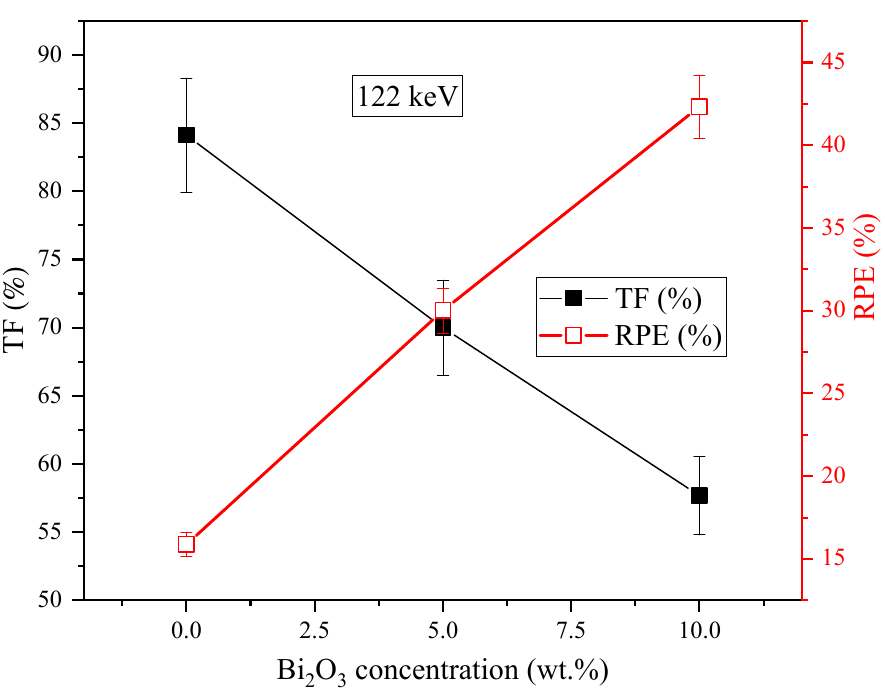
Figure 6. Dependence of transmission factor (TF, %) and RPE on the Bi 2 O 3 concentrations at a γ -photon energy of 122 keV.